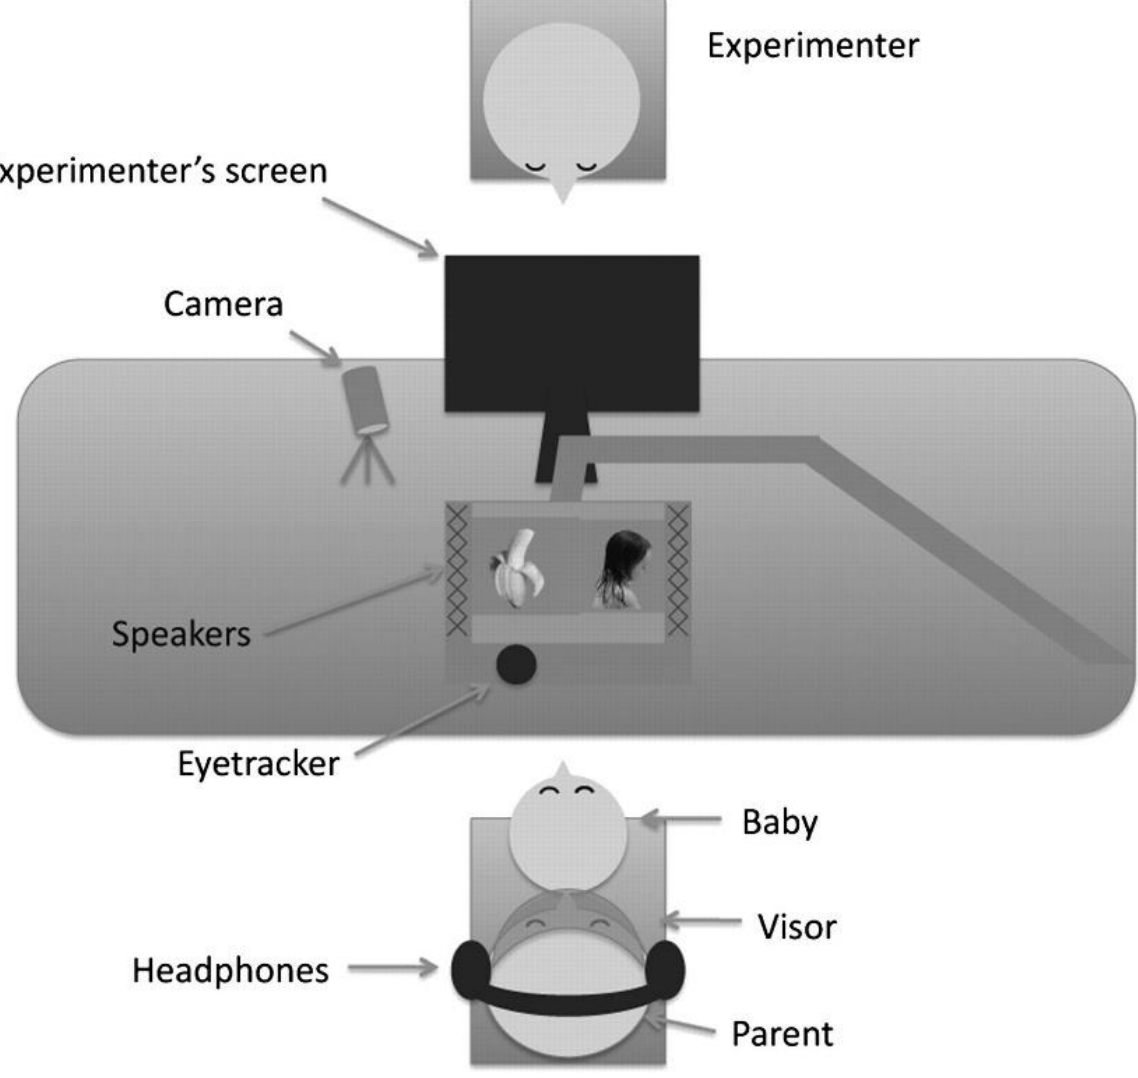
Figure 8. Example of the experimental setup used in Bergelson and Swingley (2012) (Adapted from [75]). The child sat on her parent’s lap and was presented with images on a screen and sounds from a computer equipped with an eye tracker and speakers. The researcher sat behind a screen and was not visible to the child. The experimenter controlled the presentation of stimuli and monitored the child on a live-feed camera.